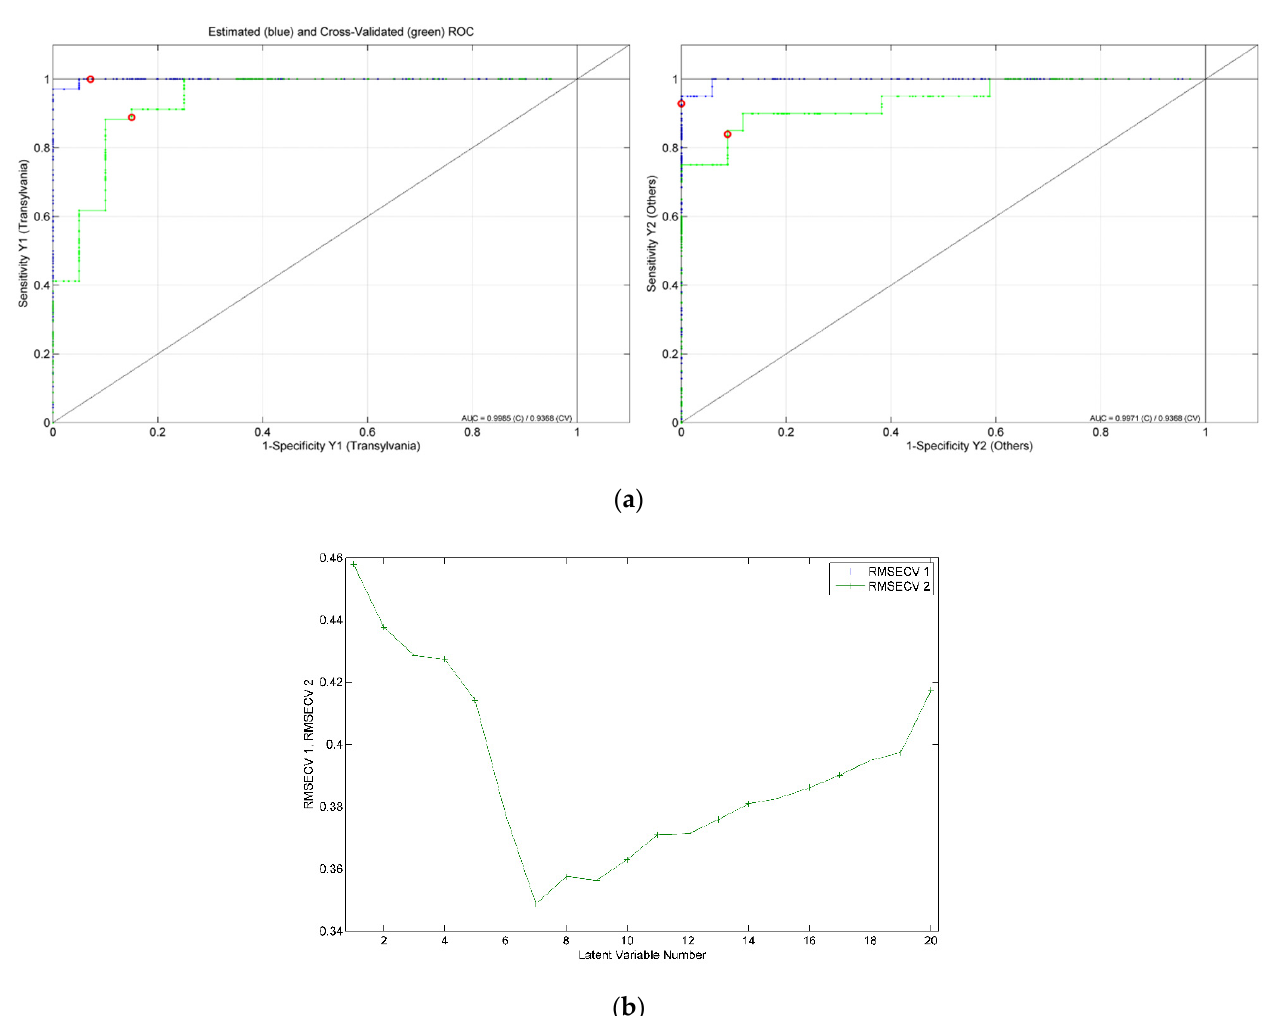
Figure 13. ( a ) ROC curves containing estimated (blue), cross-validated (green) values and model threshold (red circle), and ( b ) overlapped RMSECV plots for Transylvania (RMSECV 1—blue) and Others (RMSECV 2—green) classes associated with the PLS-DA model developed.